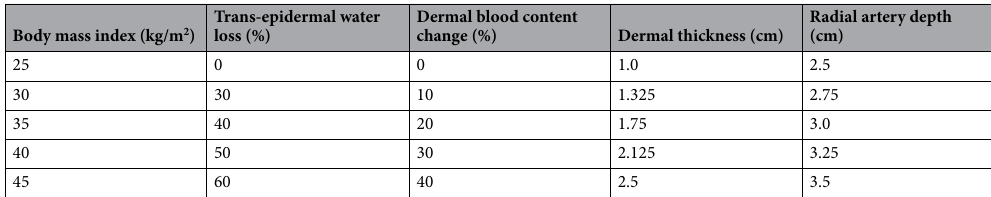
Table 3. Skin changes simulation parameters attributed with increasing body mass index and